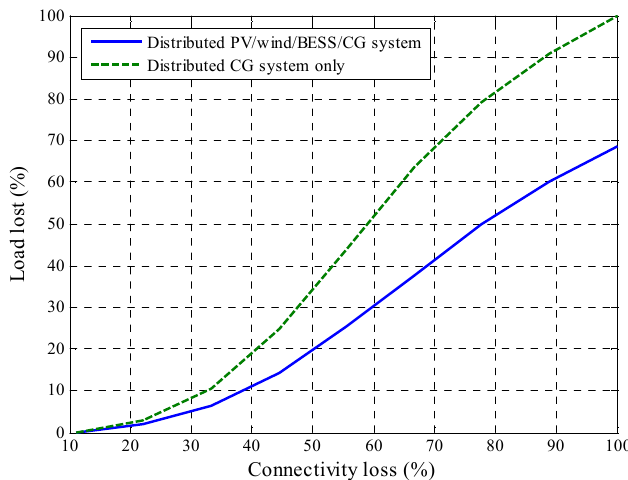
Figure 31. Vulnerability evaluation. (Distributed CG system under CIC).